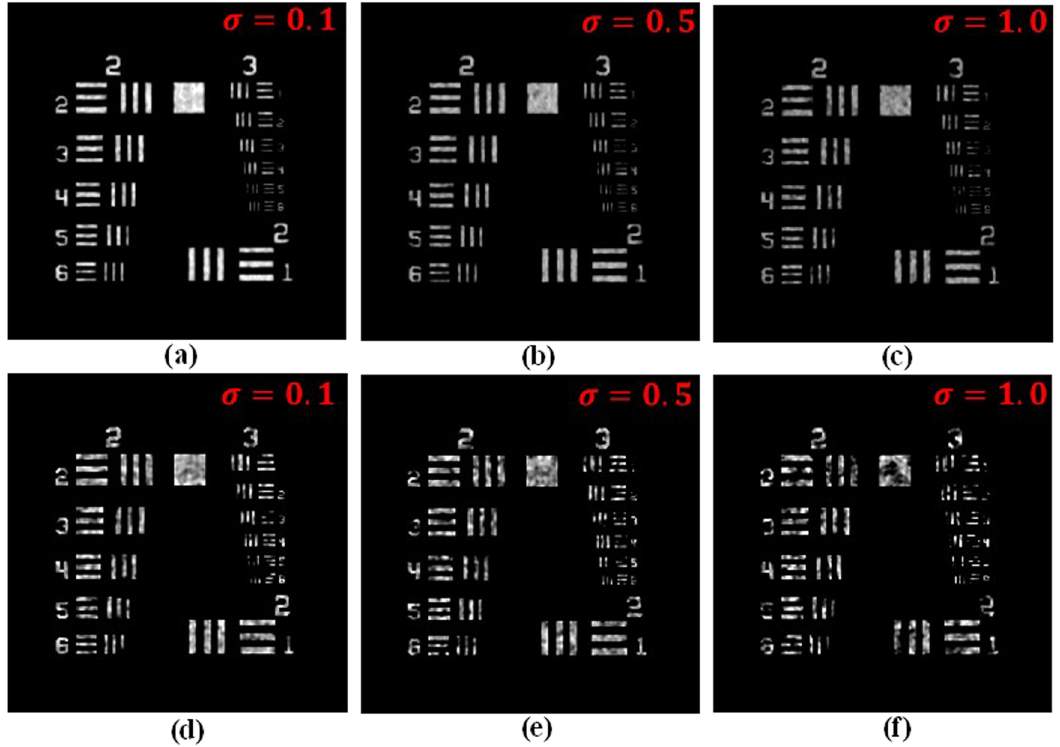
Figure 5: Reconstructed complex object wave using CS method ( a – c ) intensity and ( d – f ) the corresponding